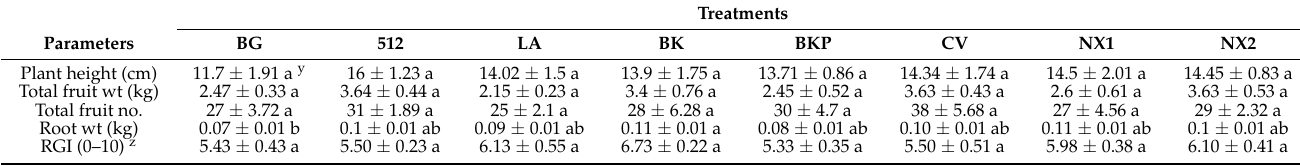
y Means ± standard error ( n = 4) are from repeated measures over 10 sampling dates for total fruit number/plot and total fruit weight/plot. Means ± standard error ( n = 16) for root-gall index, root weight, and plant height per plant/plot. Values followed by the same letter(s) in a row are not different based on Waller–Duncan k -ratio ( k = 100) t -test. z RGI = Root-gall index on a 0–10